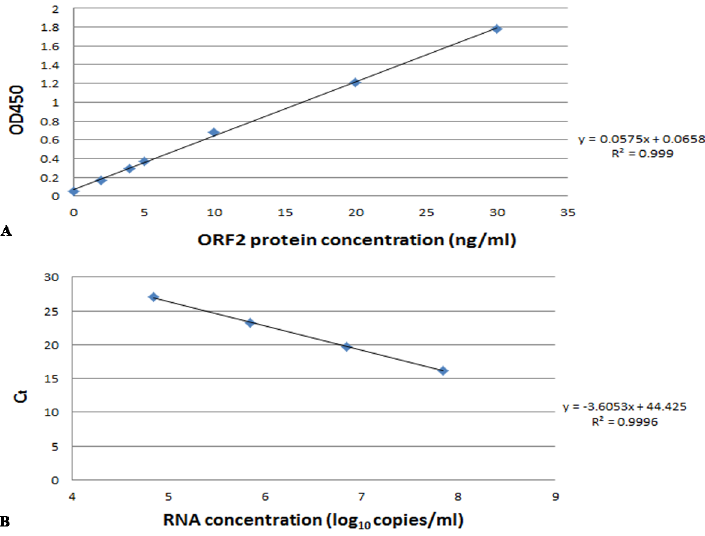
Fig 1. The standard curve of ORF2protein (A) and HEV RNA (B). (A): The X-axis is the concentration of ORF2 protein standard and Y-axis is the value of OD 450 . (B): X-axis is the concentration of HEV RNA standard and Y-axis is the Ct value of real time